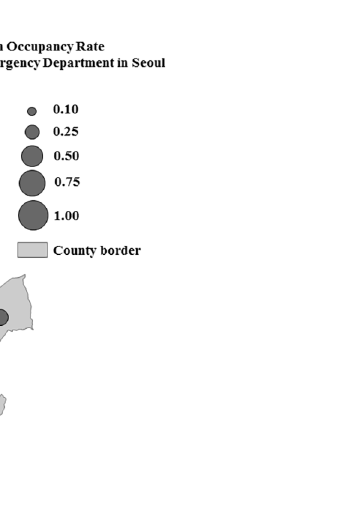
Table 1. Characteristics of the study population. Variables (cid:1) 0.5 > 0.5 to (cid:1)